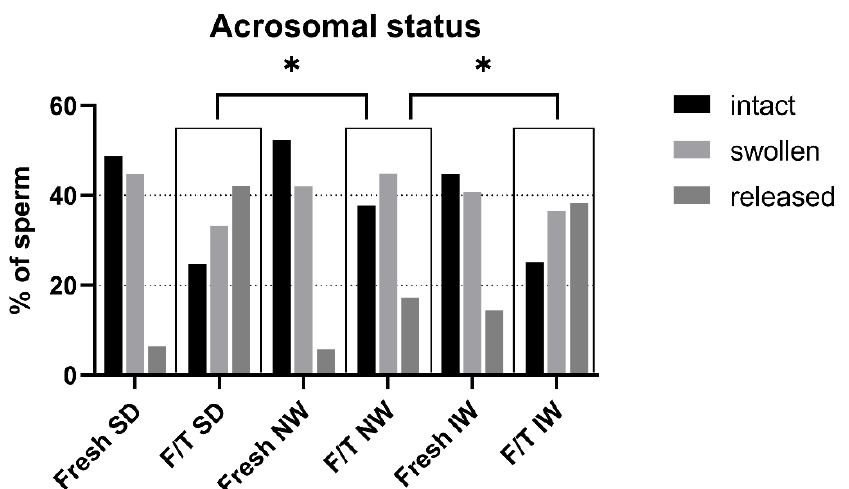
Figure 6. Acrosomal status of fresh and F/T sperm in each breed. F/T—frozen/thawed, SD—Slovak Dairy, NW—Native Wallachian, and IW—Improved Wallachian. * Distribution of sperm to the quality classes in F/T NW group differ significantly ( p < 0.05) from distribution in F/T samples of other breeds.